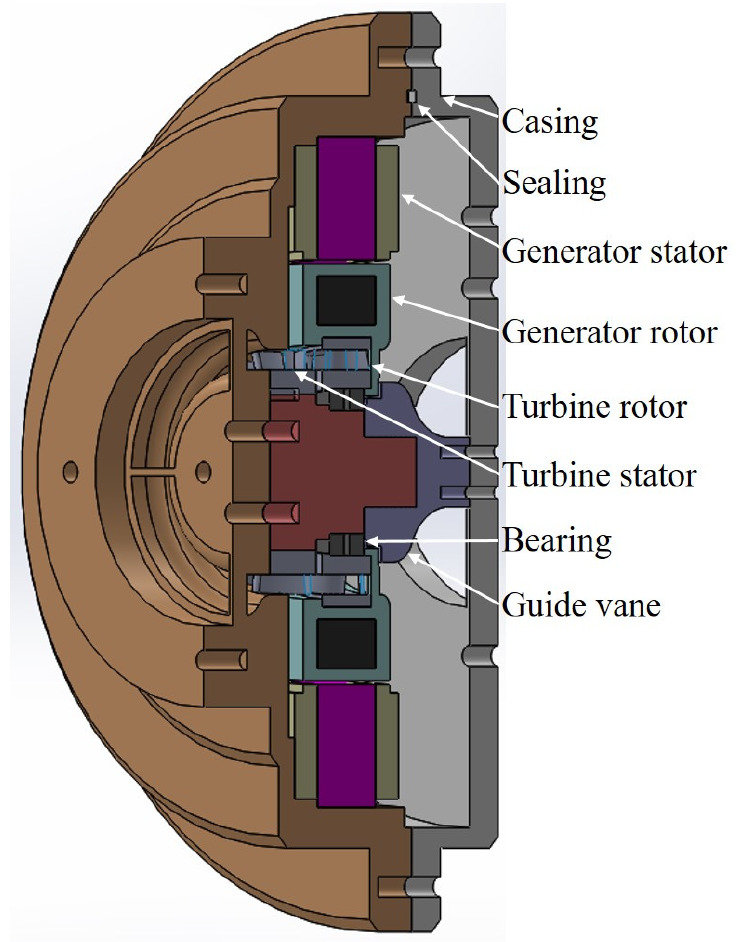
Figure 13. Proposed 3D turbine generator assembly with TEG structure.